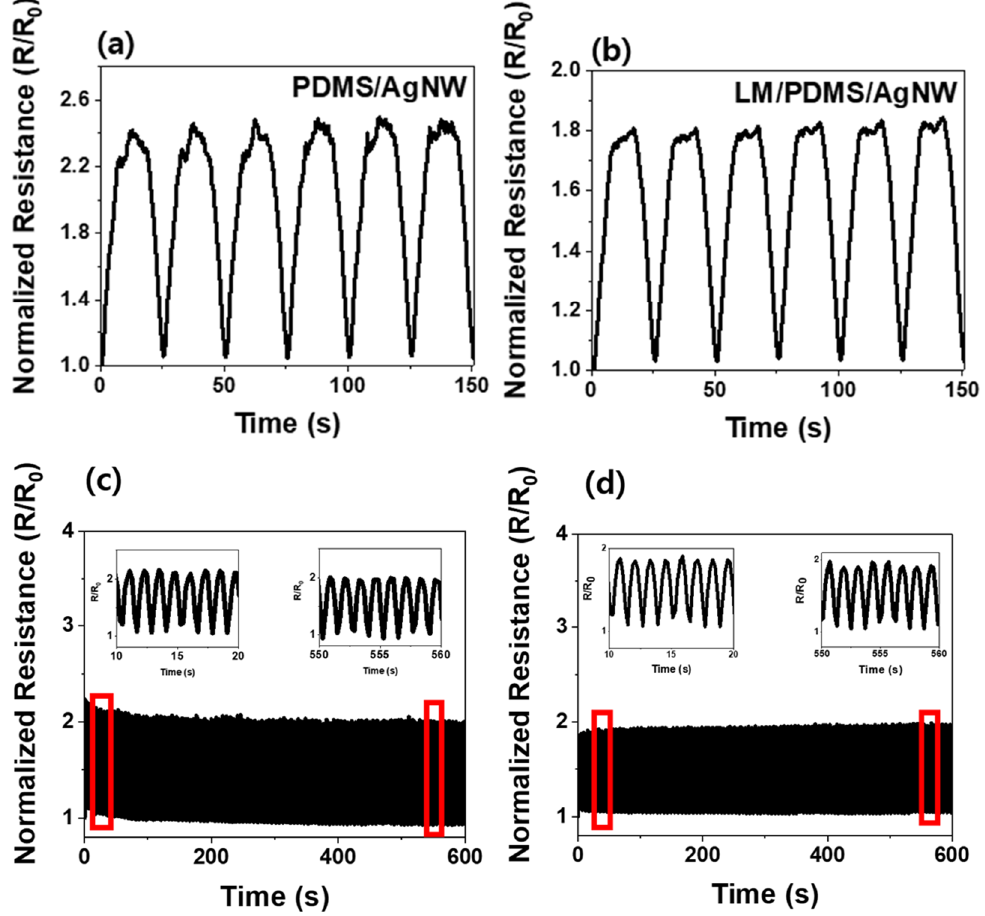
Figure 3. Normalized resistance versus time of PDMS/AgNW and LM/PDMS/AgNW under applied tension: low-speed cyclic test (six cycles) of ( a ) PDMS/AgNW and ( b ) LM/PDMS/AgNW sponge. High-speed cyclic test (500 cycles) of ( c ) PDMS/AgNW and ( d ) LM/PDMS/AgNW sponges. The insets show magnified views of regions outlined in red.